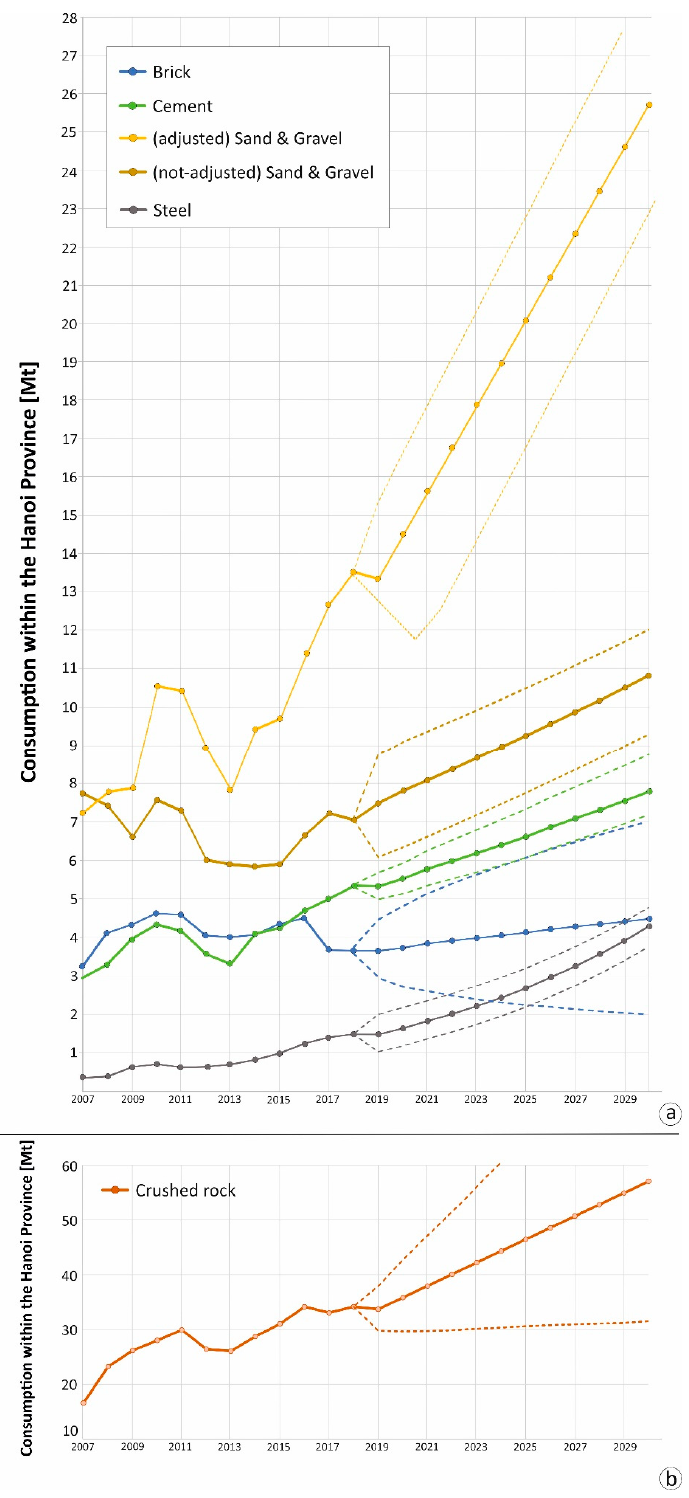
Figure 5. Projections and confidence intervals (dotted lines) for consumption of construction materials within the Hanoi Province for bricks, cement, (adjusted) sand and gravel, (not-adjusted) sand and gravel and steel ( a ) and crushed rock aggregates ( b ). Note: a different scale for the consumption projection of crushd rock is